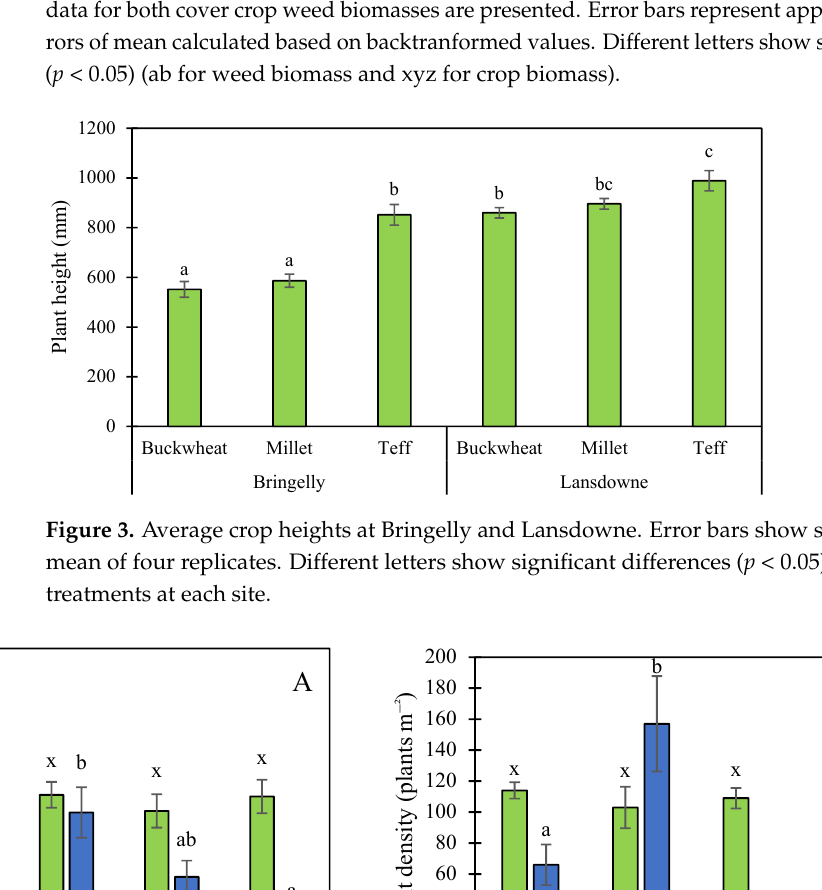
Figure 5. Wheat crop establishment and the emergence of weeds in the control ( A ) and teff ( B ) plots at Bringelly site in winter (June) 2021.